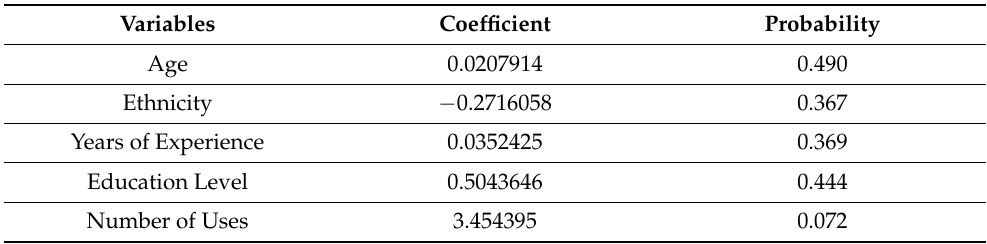
Table 1. Results of the simple linear regression.